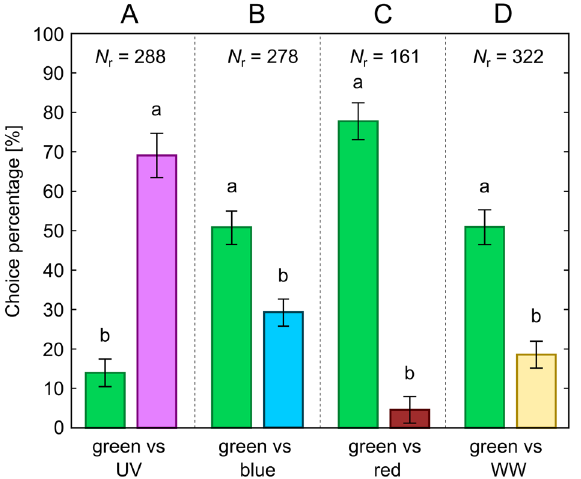
Figure 7. Percentage of choices of fungus gnats for the four different stimulus pairs in type 3 trials in behavioural experiment 2. ( A ) Results for the green-UV stimulus pair (Fig. 3C) with vertical bars denoting SD. Lowercase letters indicate statistically homogeneous groups at α = 0.05 significance level revealed by Games- Howell post-hoc test. Choice percentages for the four unexposed chambers are not displayed. N r is the number of respondent fungus gnat individuals out of the total number of 500 tested specimens. Total number of trials was 10. ( B ) Same as A, for the green-blue stimulus pair (Fig. 3D) but with Tukey’s post-hoc test. ( C ) Same as ( B ), for the green-red stimulus pair (Fig. 3E). ( D ) Same as ( B ), for the green-WW stimulus pair (Fig.